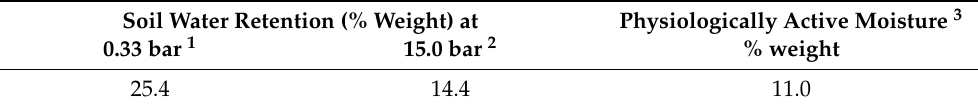
Table 3. Water retention capacity of the soil used in the